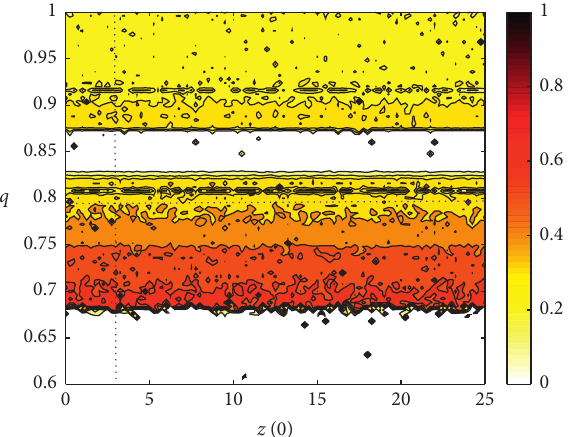
Figure 12: C 0 complexity in the z (0)- q